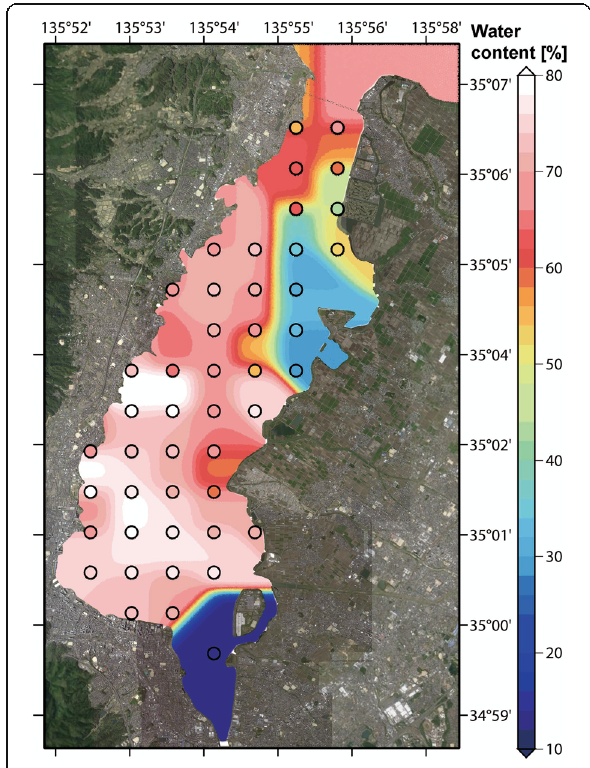
Fig. 5 Map of the moisture content (%) of the lakebed of the southern basin. Colored dots indicate the observational site moisture contents observed in September 2002 (Haga et al.